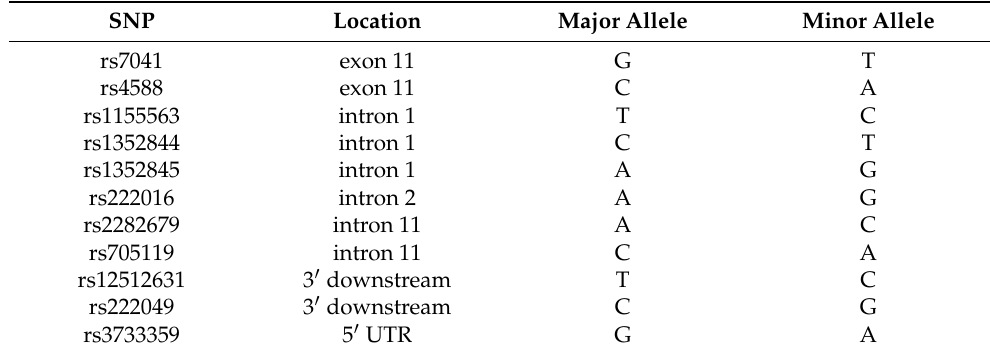
Table 2. SNPs alleles and chromosome location (based on SNPedia